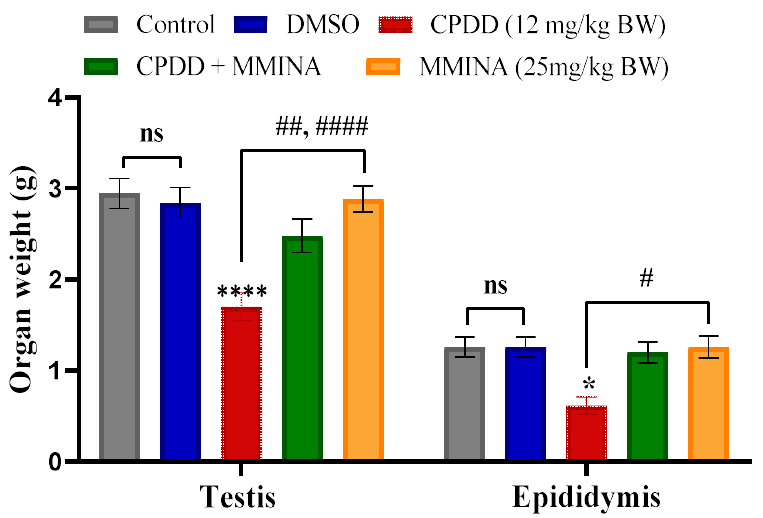
Figure 1. Effect of various treatments on organ weights. *, **** p < 0.05 and p < 0.0001 versus Control